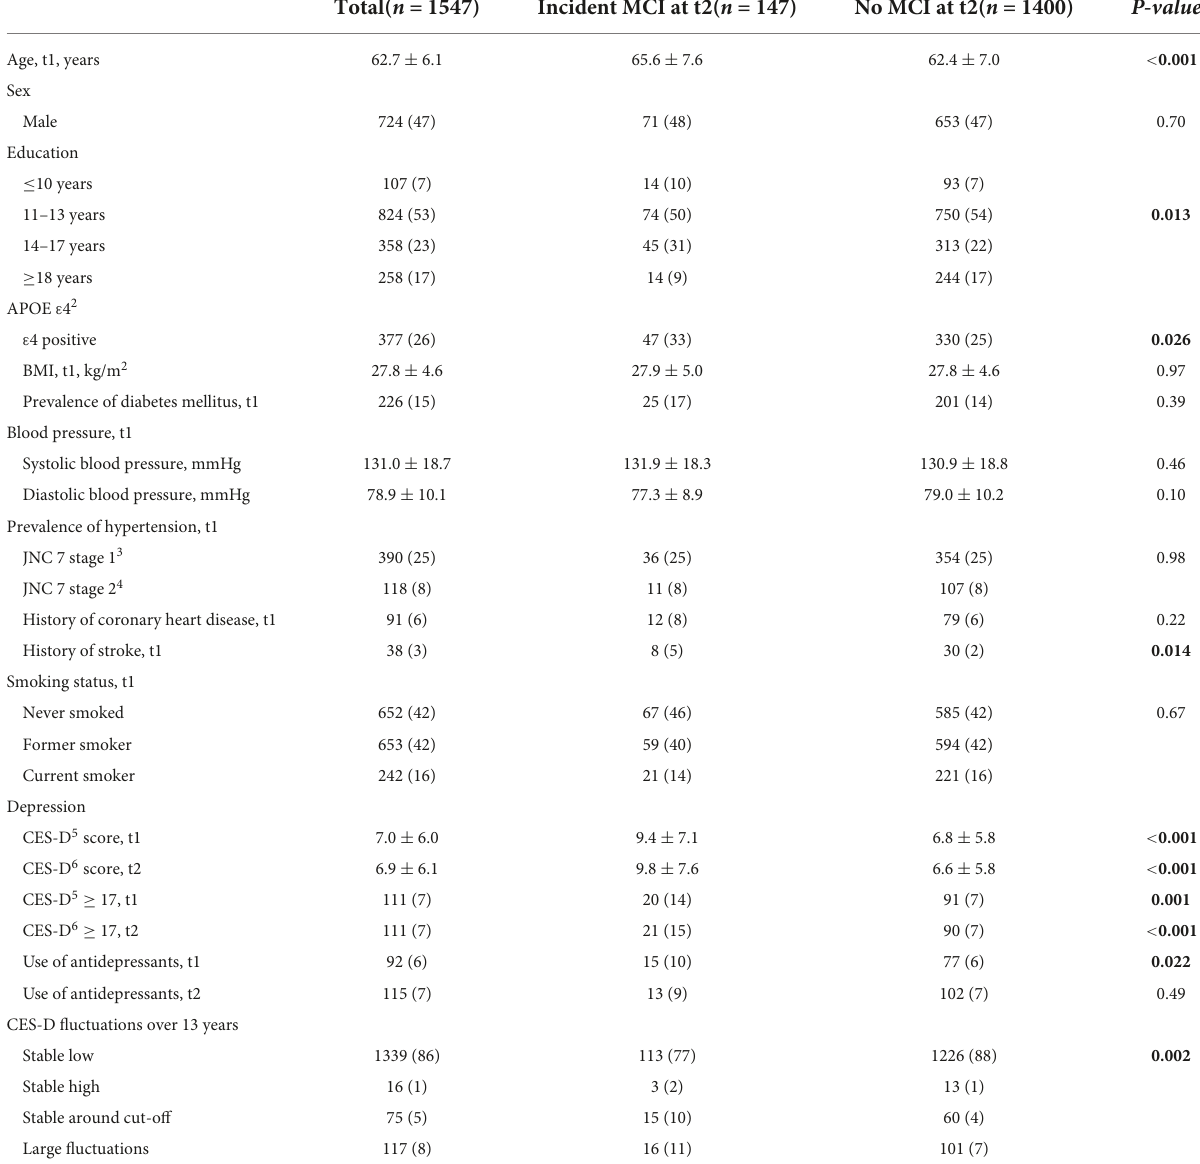
TABLE 1 Demographic and clinical characteristics of all study participants and stratified by incident mild cognitive impairment (MCI) vs. no MCI at